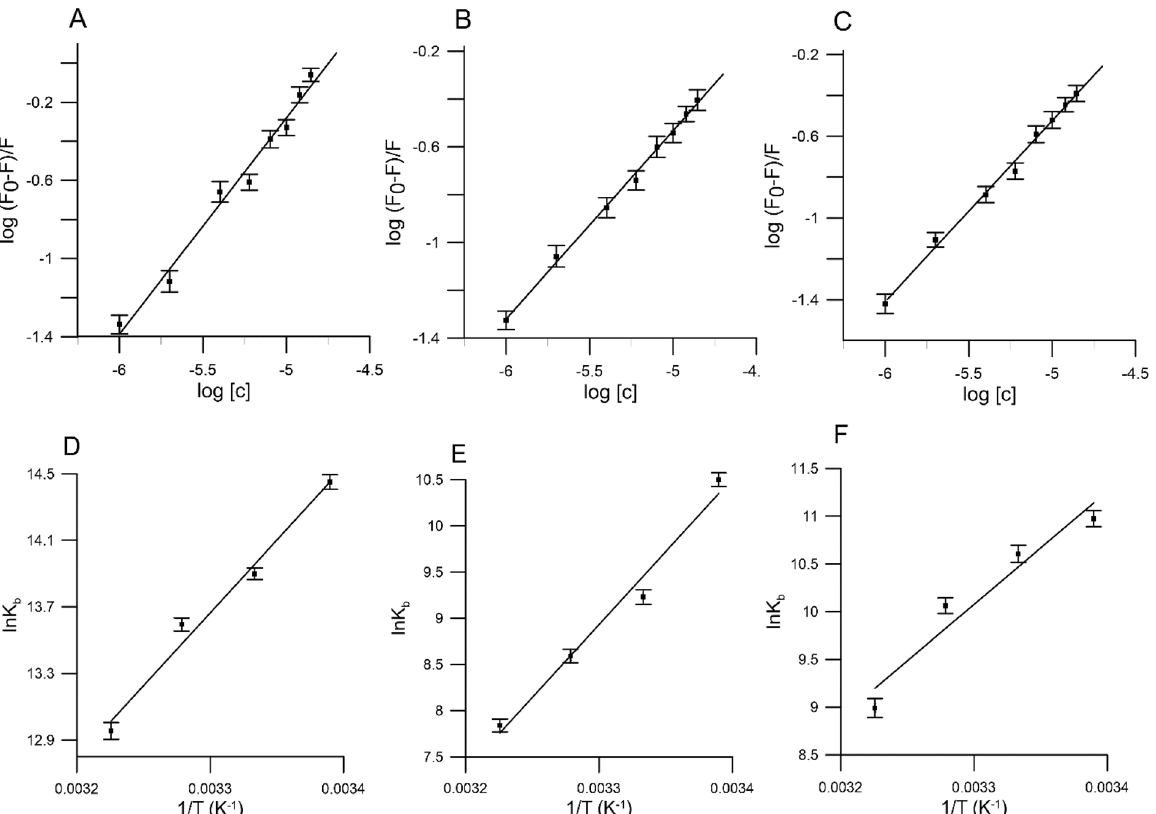
Figure 6. The plots of log( F 0 − F )/ F versus log[ c ] of ( A ) 2 ′ -hydroxy-4 methyl chalcone, ( B ) 4 ′ -methylflavanone, ( C ) 4 ′ -methylflavone at 310 K and van’t Hoff plot for temperature dependence of K b obtained from HSA fluorescence quenching by ( D ) 2 ′ -hydroxy-4 methyl chalcone, ( E ) 4 ′ -methylflavanone and ( F ) 4 ′